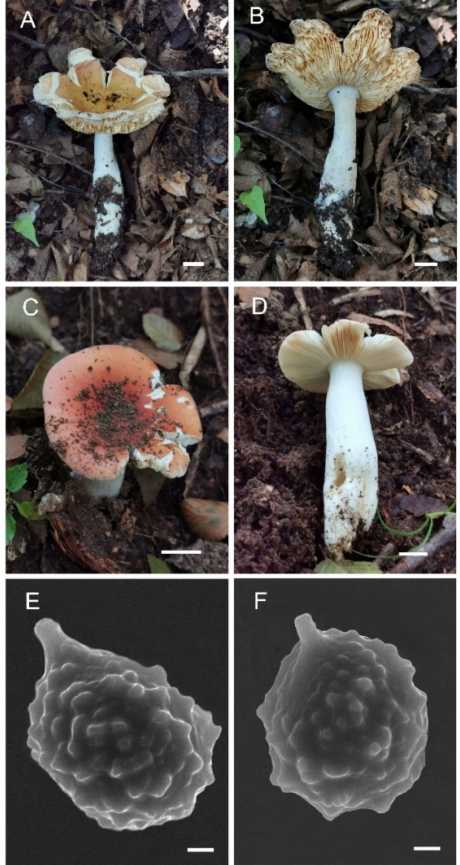
Figure 3. Russula miyunensis (BJTC Z1355). ( A – D ) Basidiomata. ( E , F ) Basidiospores. Scale bar: ( A – D ) = 10 mm, ( E , F ) = 1 µ m.